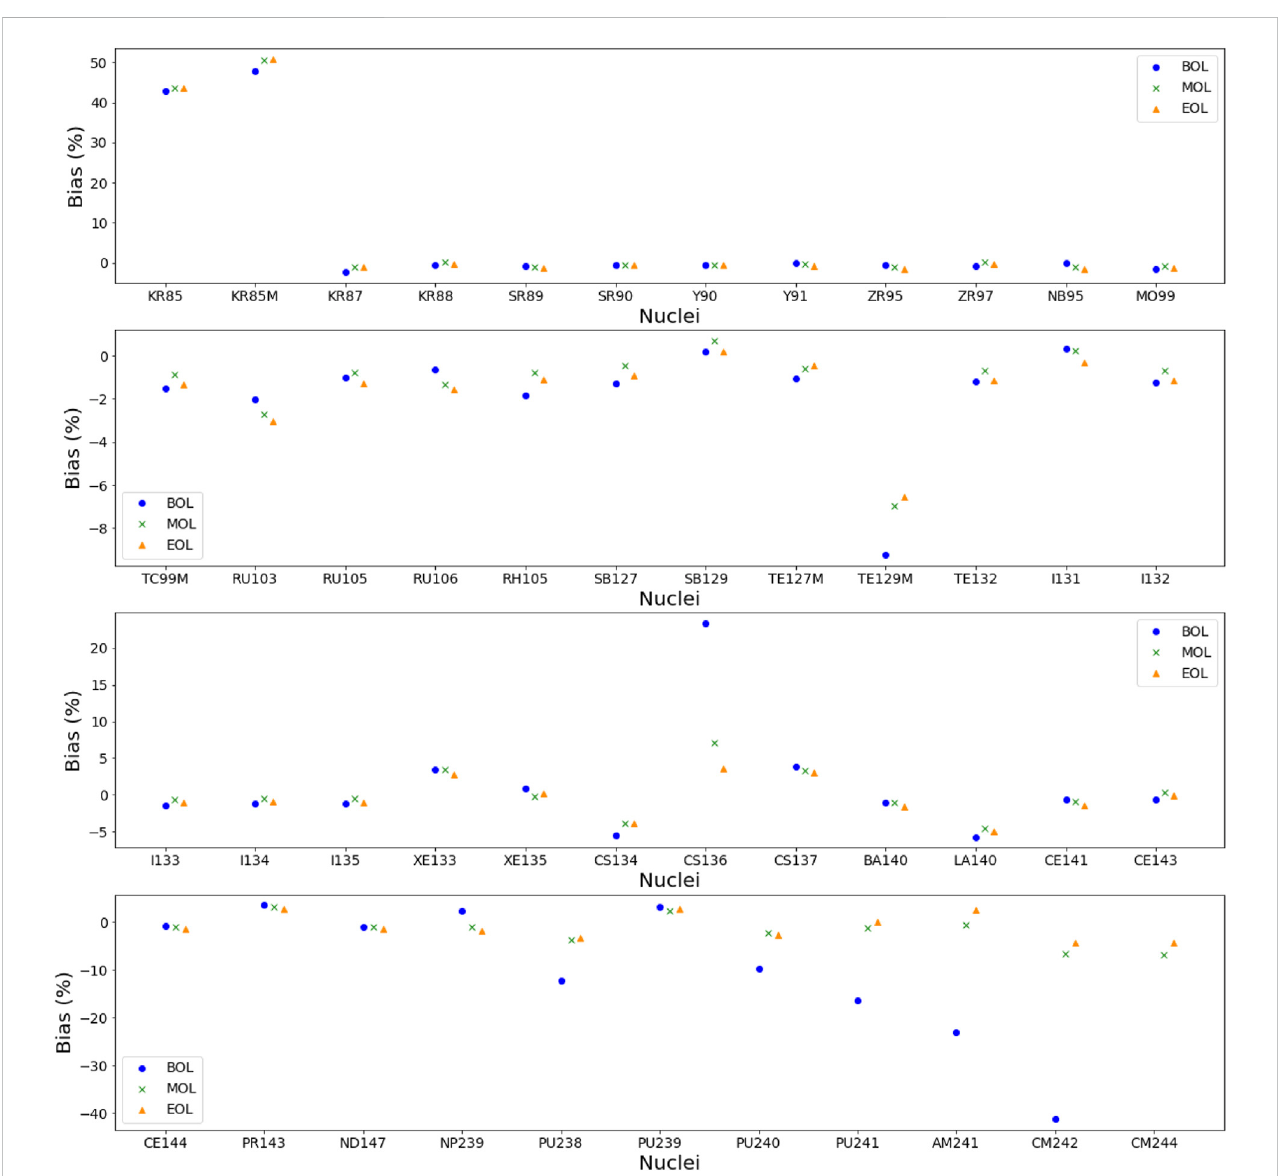
Bias due to the resolution method ε i code (between CASMO and VESTA) on the assembly nuclide inventory, for three burnup values, for UO 2